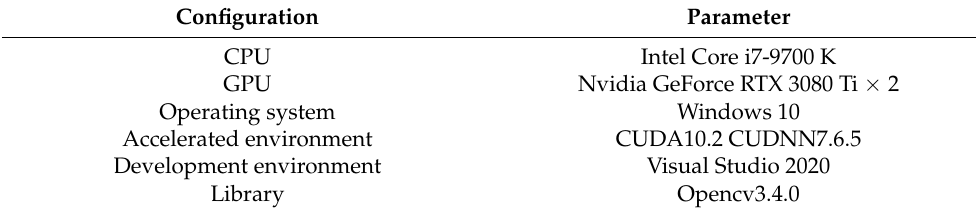
Table 2. The experimental